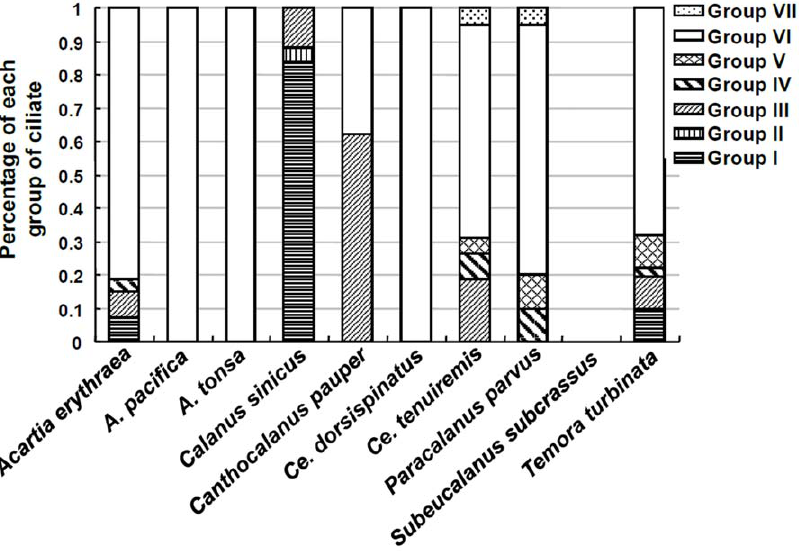
Figure 4. Relative abundance of each ribogroup of ciliate symbionts out of total symbiotic ciliate sequences. Fraction was calculated as the sequence number of each ribogroup divided by the total number of symbiotic ciliate sequences obtained from each copepod species. Data from starved copepods were not included in this figure because the total number of clones sequenced for each species was generally low precluding the possibility to achieve reliable fraction values.